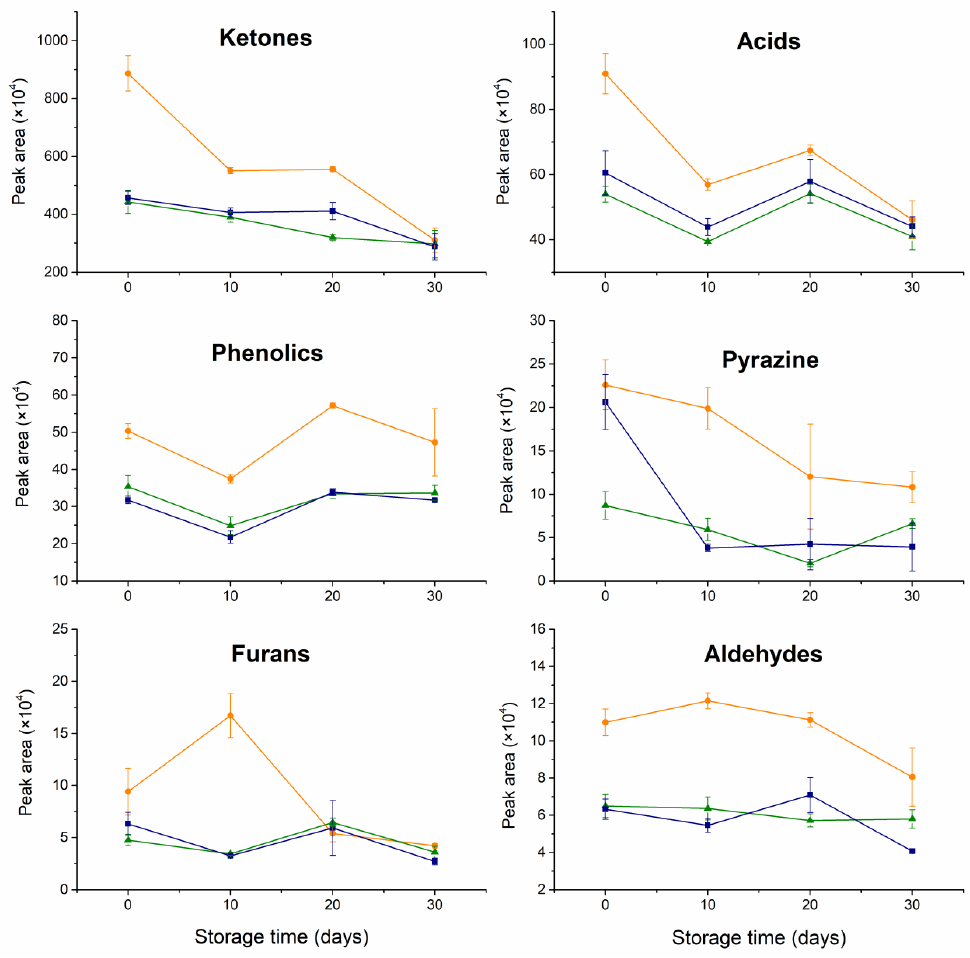
Figure 4. The effects of storage on the spray-dried ( ), freeze-dried ( ), and non-encapsulated RCO ( ) on the peak areas of specific compounds.